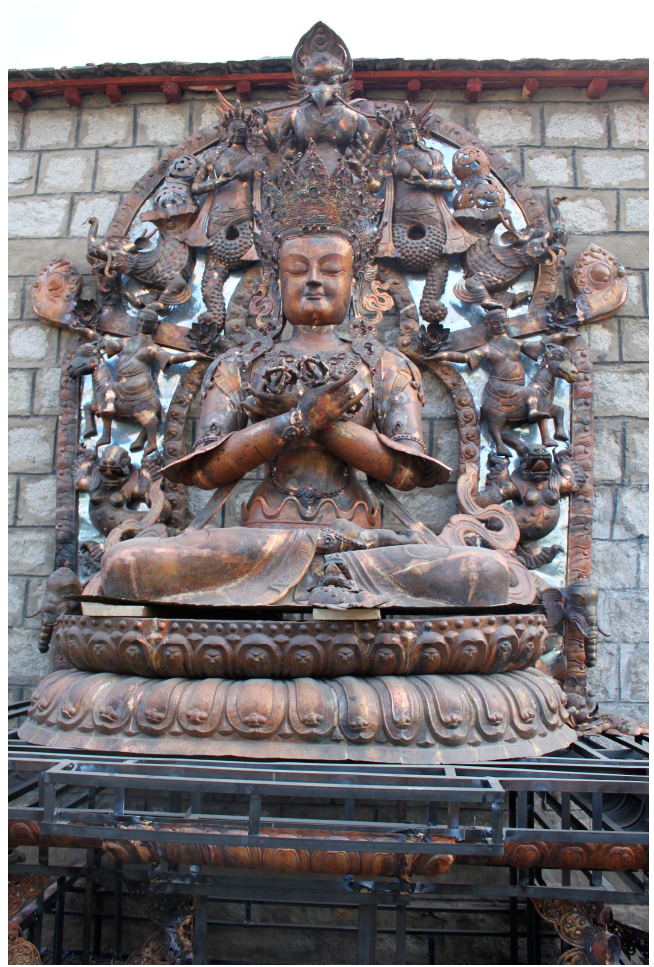
Figure 4. Unfinished metal statues in a Buddhist art workshop near Sera Monastery, Lhasa, Tibet (photo C. Bellini 2012).